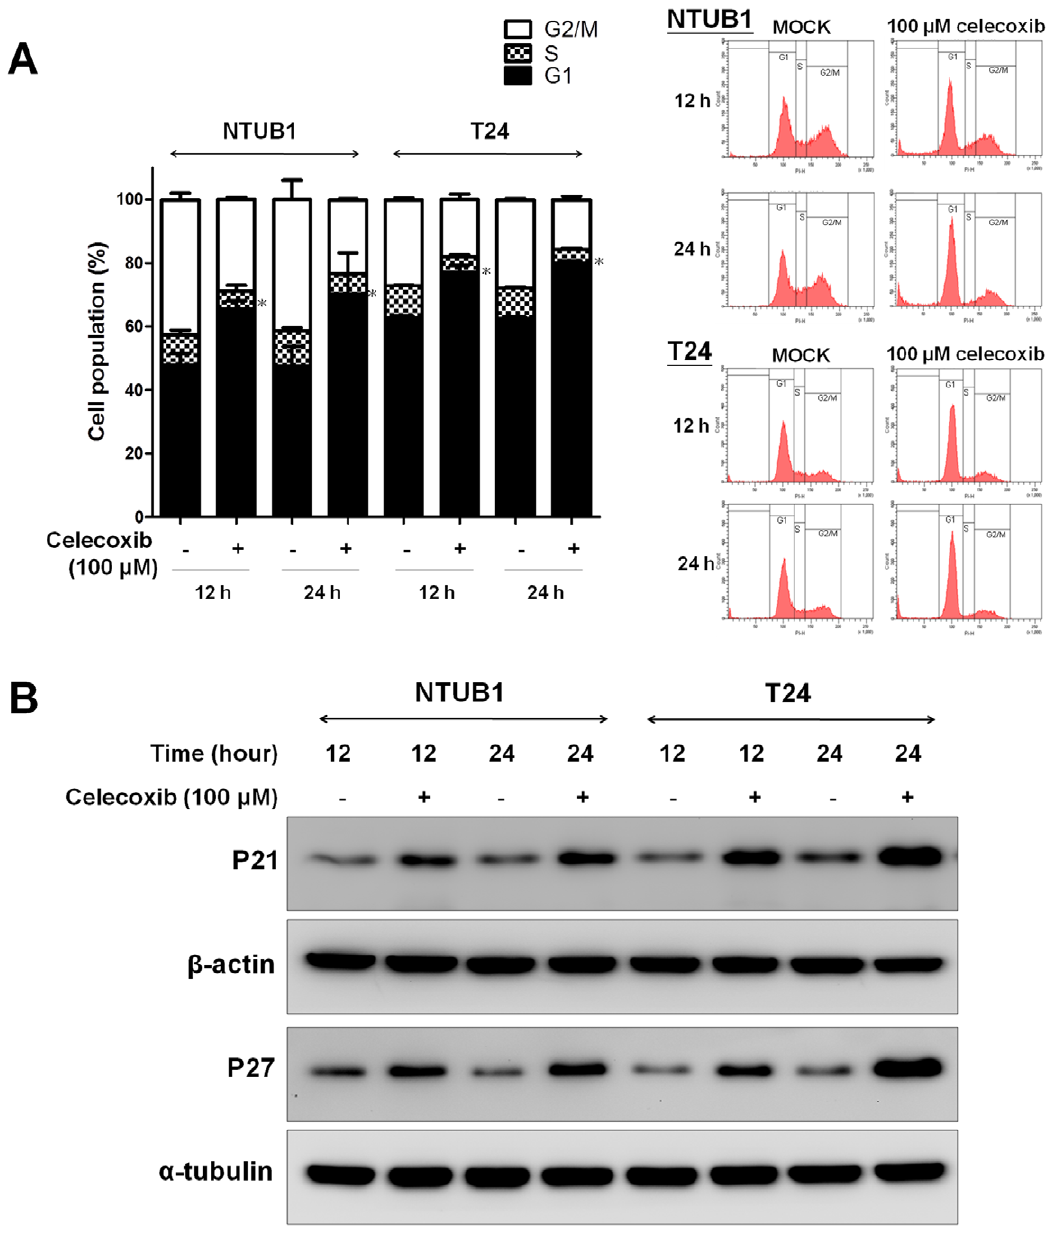
Figure 2. Celecoxib caused cell cycle arrest at G1 phase in NTUB1 and T24 UC cells. (A) NTUB1 and T24 cells were treated with mock (untreated) or celecoxib (100 m M) for 12 and 24 h, and cell cycle analysis was measured as described in Materials and methods. Data are presented as means 6 SD of three independents experiments. * p , 0.05 as compared with control. (B) The expressions of p21 and p27 at 12 and 24 h after celecoxib treatment were analyzed by Western blotting. Results shown are representative of at least three independent